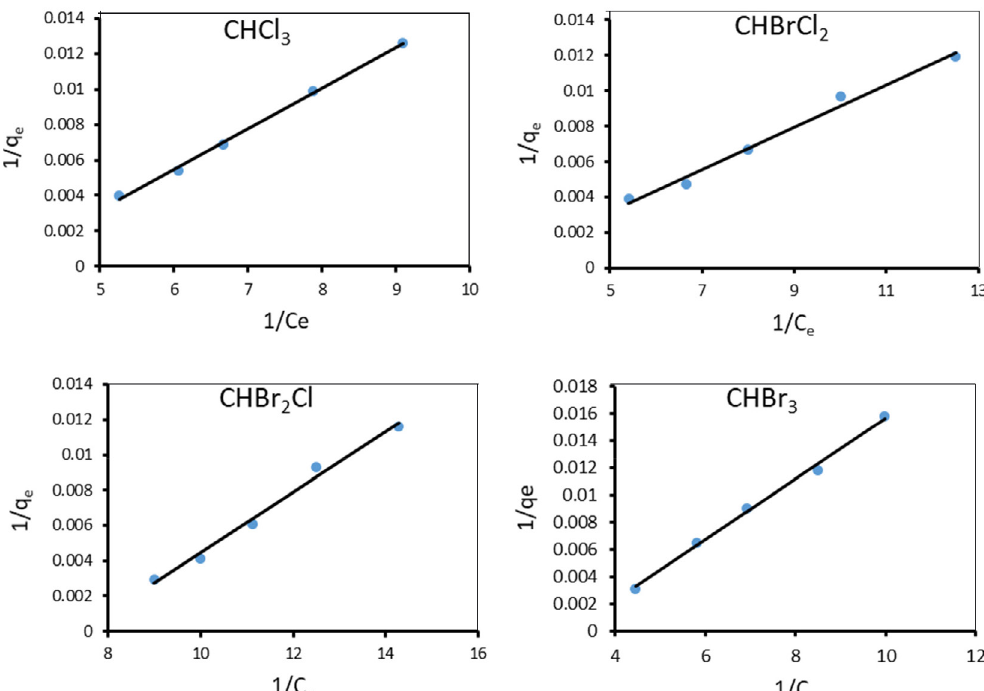
Figure 7. The Langmuir isotherm charts for